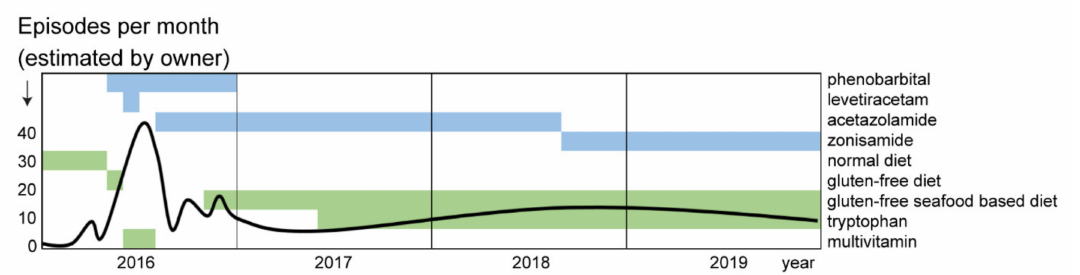
Figure 3. Frequency of dyskinetic episodes in case 4. The estimated frequency of episodes per month (black line), contemporaneous medications and diets are displayed with green and blue bars, respectively. A combination of seafood-based, gluten-free diet with supplementation of tryptophan and treatment with acetazolamide or zonisamide seemed to reduce frequency of episodes.